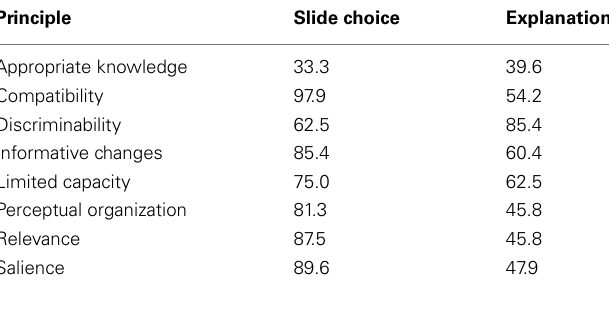
Table 6 | Percentage of participants who made at least one error in slide choice per principle, and percentage of participants who (given they made the correct slide choice) made at least one error in explanation per principle, in Study